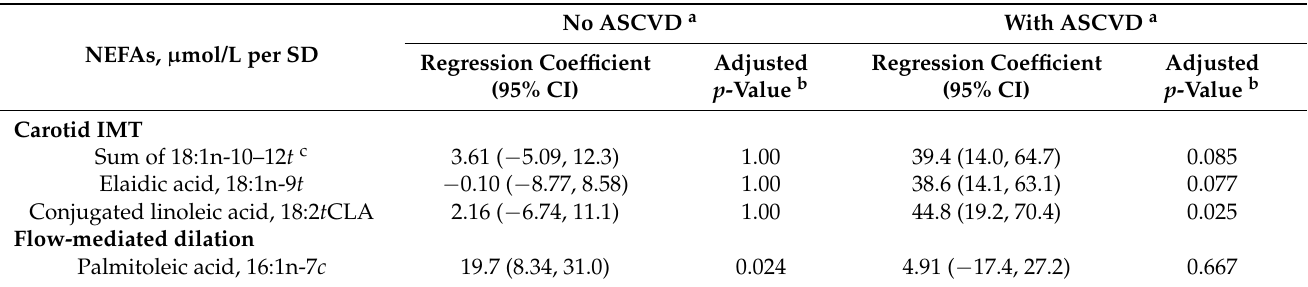
Table 2. Selected associations of serum individual non-esterified fatty acid (NEFA) with carotid intima-media thickness (Carotid IMT) and flow-mediated dilation (FMD) in the Cardiovascular Health Study cohort,